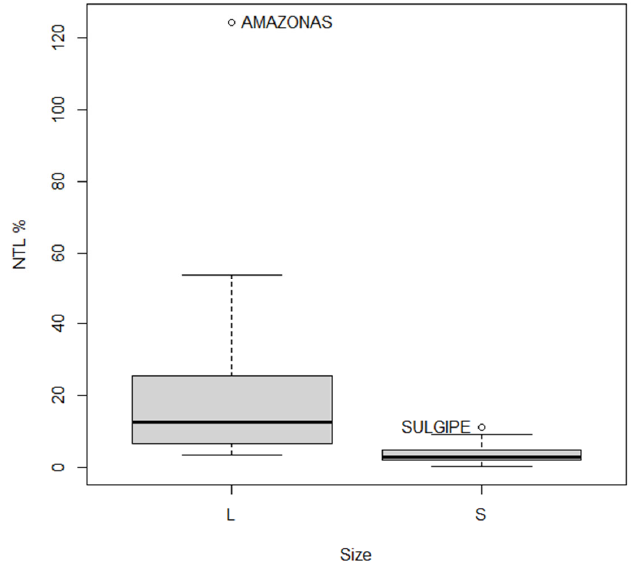
Figure 4. NTLs by size of concession area.